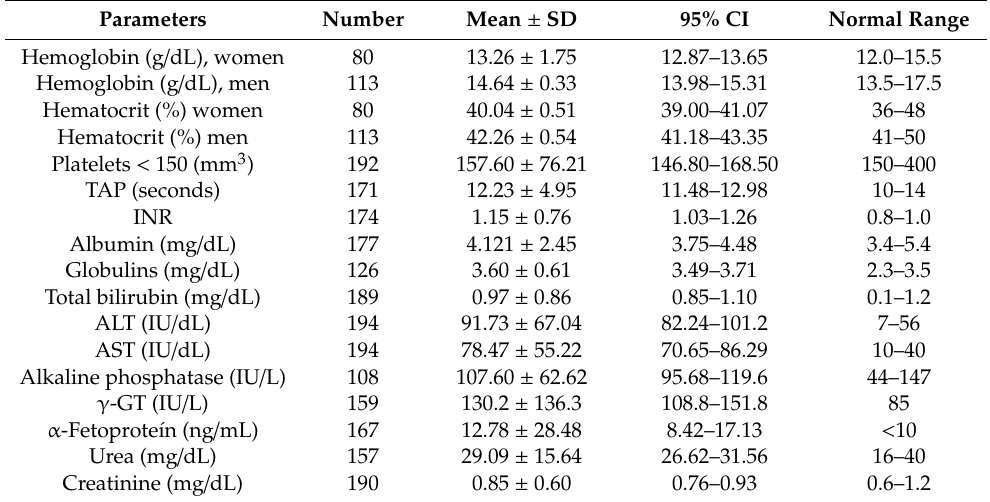
Table 2. Baseline laboratory parameters of the patients with chronic hepatitis